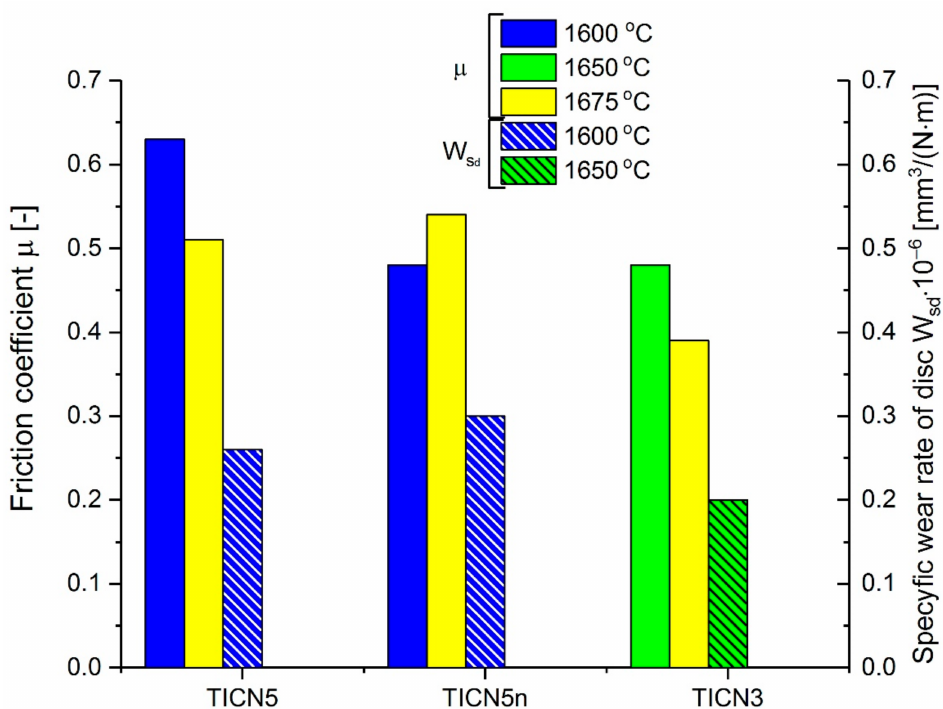
Figure 10. Mean values of the friction coefficient ( µ ) and the disc wear rate ( W s d ) of the Al 2 O 3 /Ti(C,N)/ZrO 2